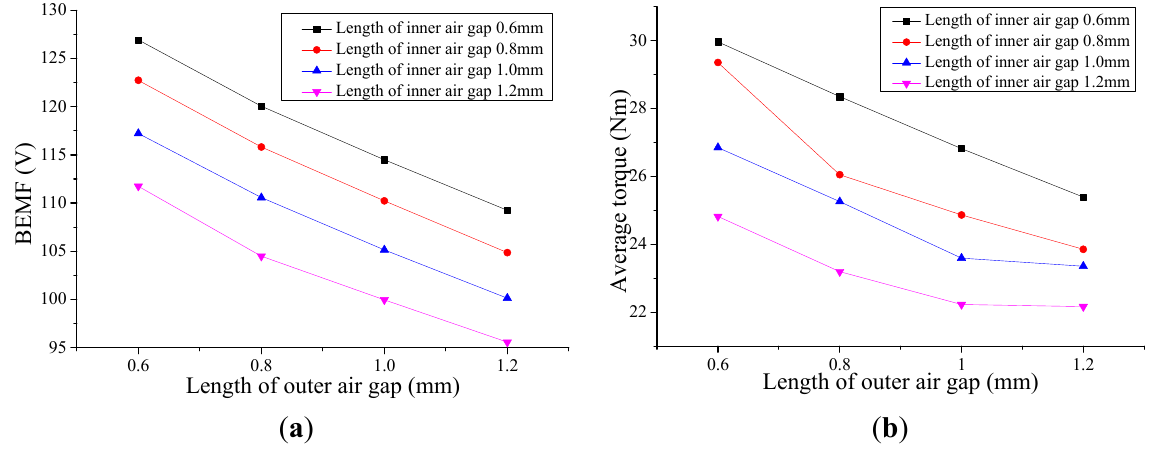
Figure 13. Variation of BEMF and average torque versus length of outer/inner air gap: ( a ) BEMF; ( b ) Average torque.